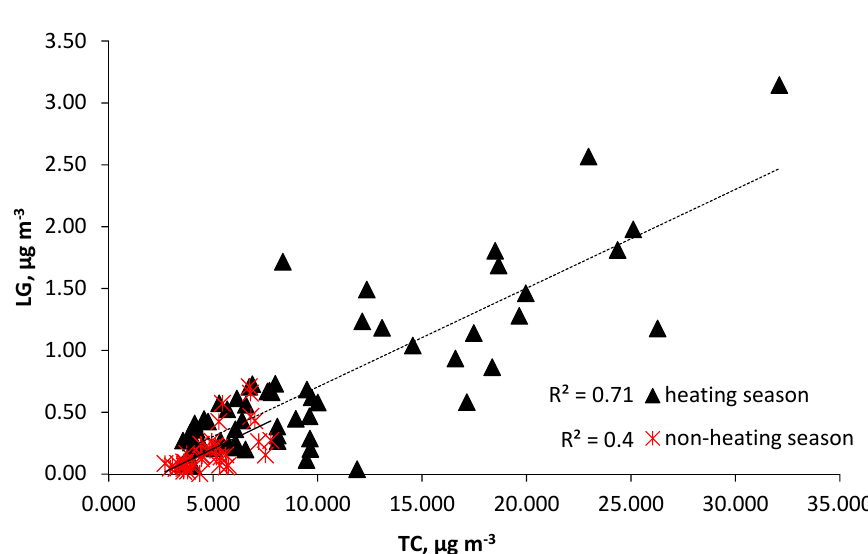
Figure 8. Relationship LG vs. TC for non-heating and heating season.